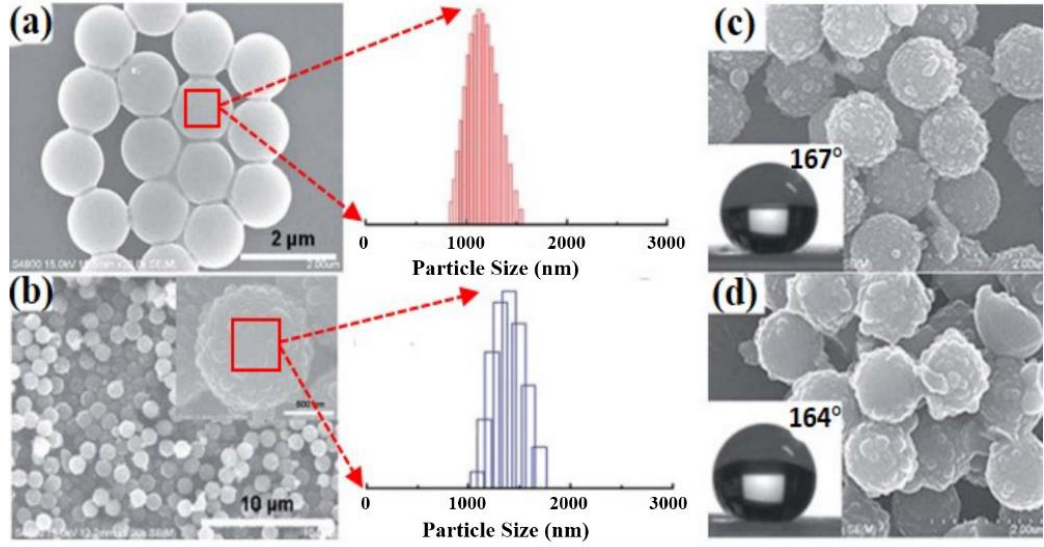
Figure 12. SEM images of the hierarchical polysilsesquioxane/polystyrene microspheres and corresponding particle size distribution: ( a ) SEM image of polystyrene latex beads with the corresponding particle size distribution; ( b ) SEM images of the hierarchical microspheres with the corresponding size distribution; and ( c , d ) SEM images of hierarchical polysilsesquioxane/polystyrene microspheres with different contents (3 and 7 mmol) of ethyltrimethoxysilane. (Adapted from [113] with permission; Copyright 2017 RSC).